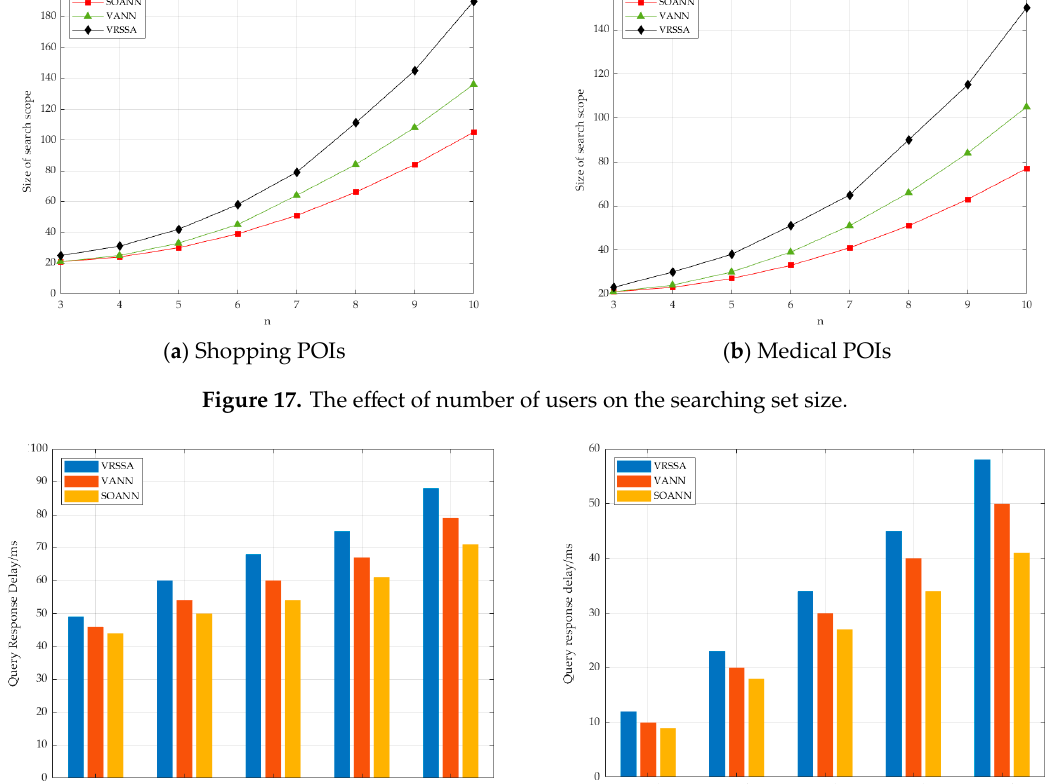
Figure 16. The effect of number of users on query response time.